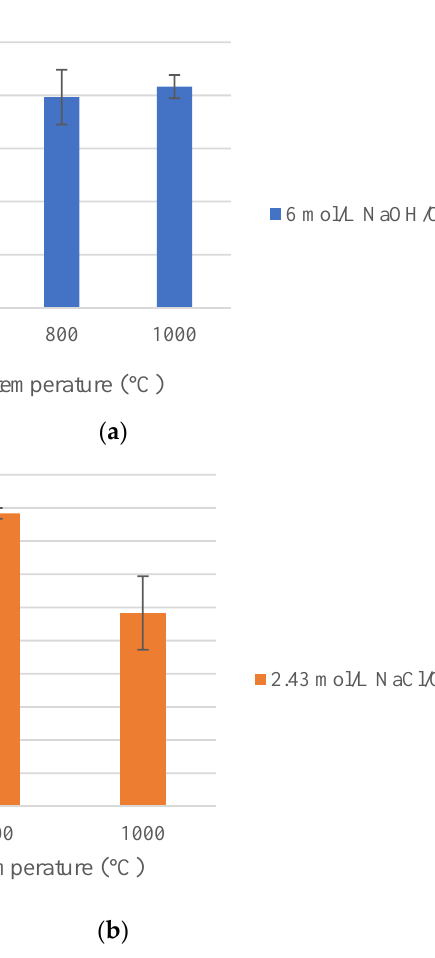
Figure 1. The FAME yield of the transesterification reaction catalyzed by various concentrations of NaOH ( a ) and NaCl ( b ) impregnated calcined oyster shell. Transesterification conditions: temperature = 62 °C; stirring rate = 800 rpm; MR = 12; CL = 10%.